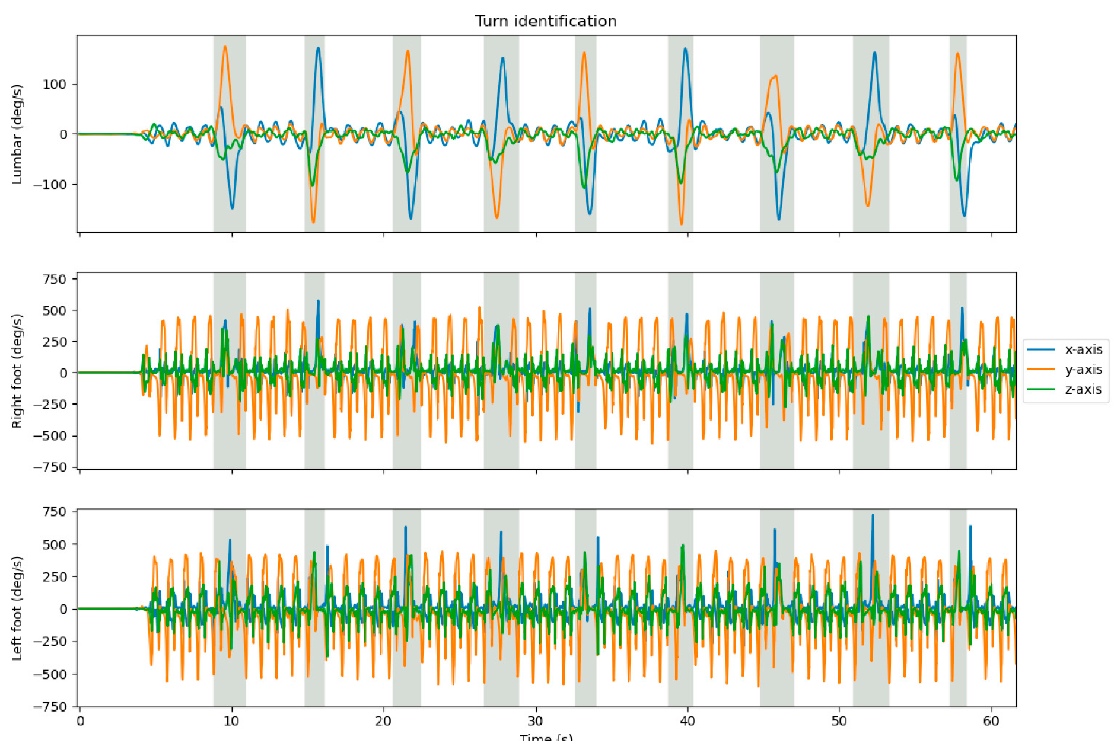
Figure 2. Stride identification was performed based on the filtered mediolateral angular velocity (green graph) and vertical free-acceleration (orange graph) signal features of the foot sensors. Ter- minal contact was determined at the local peak in vertical acceleration (green triangle pointing up), mid-swing at the peak in medio-lateral angular velocity (cross), and initial contact at zero-crossing of the medio-lateral angular velocity (red triangle pointing down).